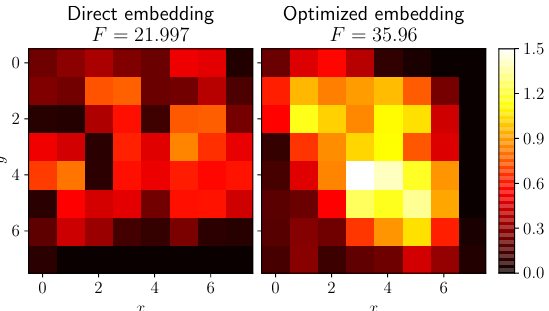
Figure 9. Each location’s mutual information (MI) to its neighbors evaluated on the direct embedding ( left ) and the optimized embedding found with the evolutionary algorithm ( right